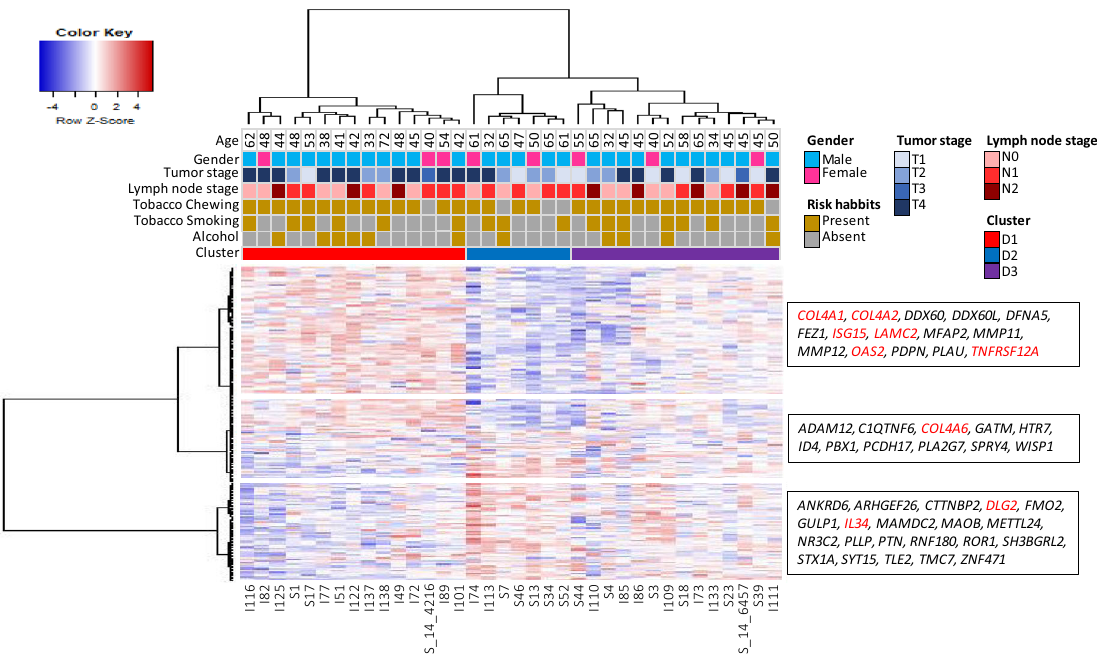
Fig. 2 Bivariate clustering of gingivo-bucal oral cancer patients and genes based on log 2 FPKM values of the 200 most signi fi cantly differentially expressed genes in the tumor samples of the 36 patients belonging to the validation cohort. Unsupervised hierarchical clustering of 36 patients identi fi ed three major clusters — D1 ( n = 15), D2 ( n = 7), and D3 ( n = 14). The 200 genes were also clustered into three groups. (From the top) The expressions of 15 (of 85), 11 (of 52), and 21 (of 63) genes (shown inside each of the three boxes) were found to progress (increase or decrease) monotonically from normal to leukoplakia to tumor. The genes marked in red belong to one or more KEGG pathways found signi fi cantly enriched in OSCC-GB